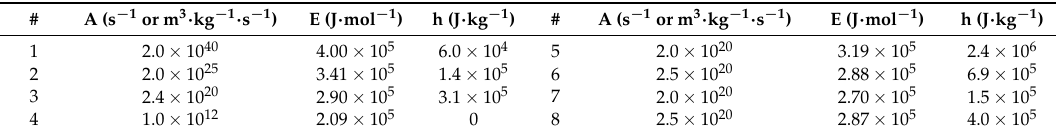
Table 3. Kinetics and thermodynamics of melting and decomposition reactions. Positive heats of reaction, h, correspond to endothermic processes.